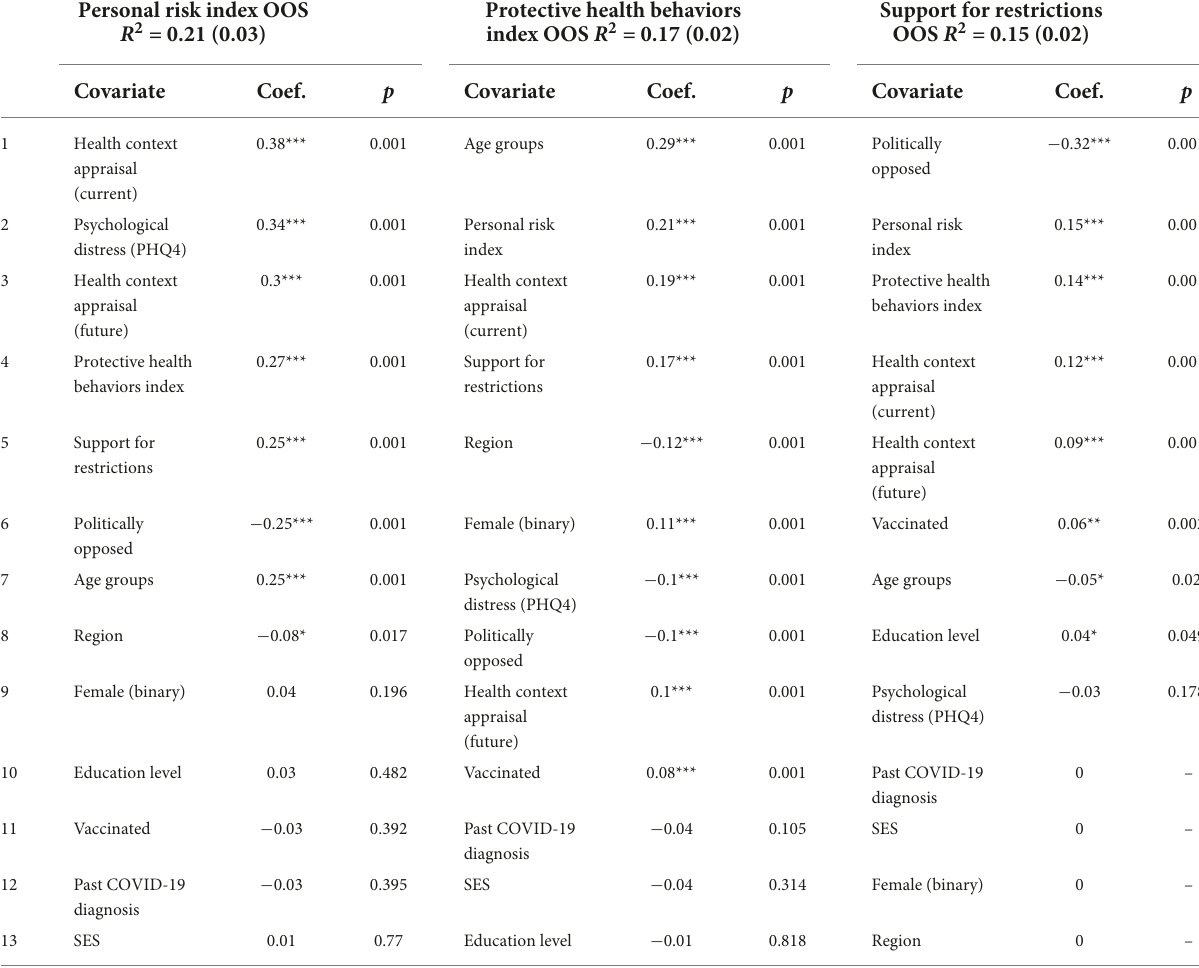
TABLE 5 Predictive performance and coefficients for LASSO